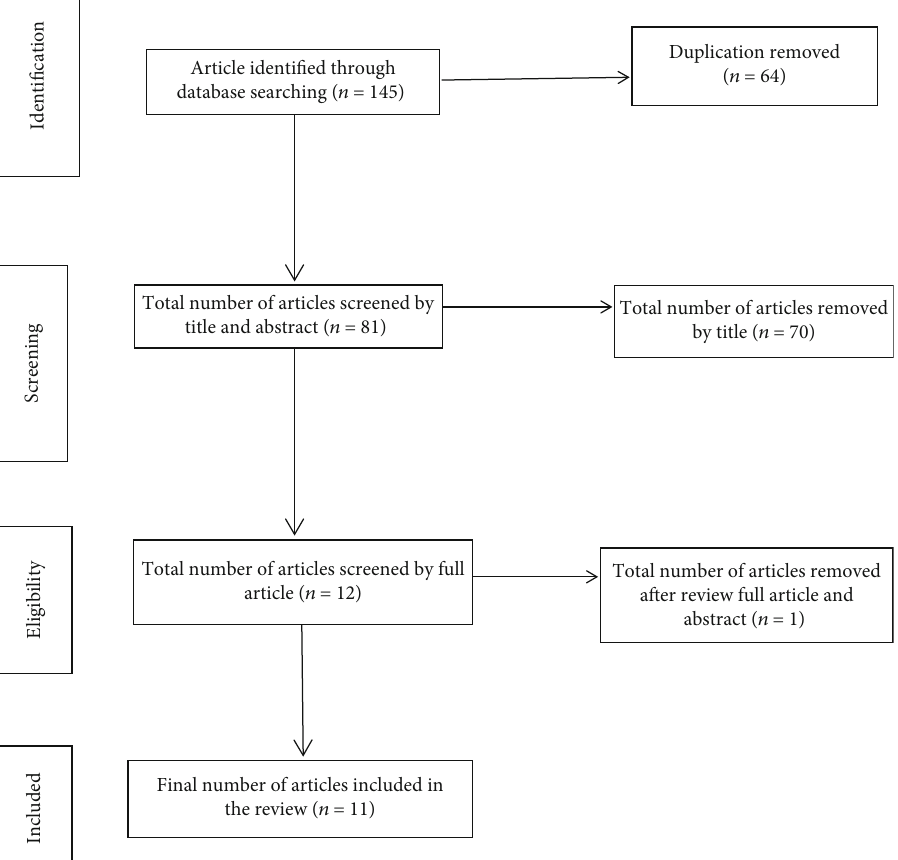
Figure 1: Flow diagram of study selection for systematic and meta-analysis of dual contraceptive use in Ethiopia.